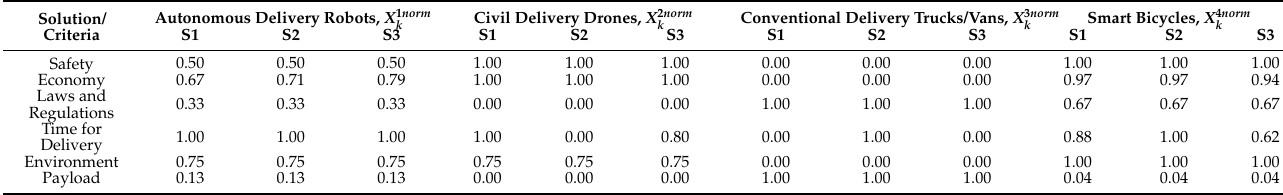
Table 7. After normalizing scores in the case of all the scenarios.